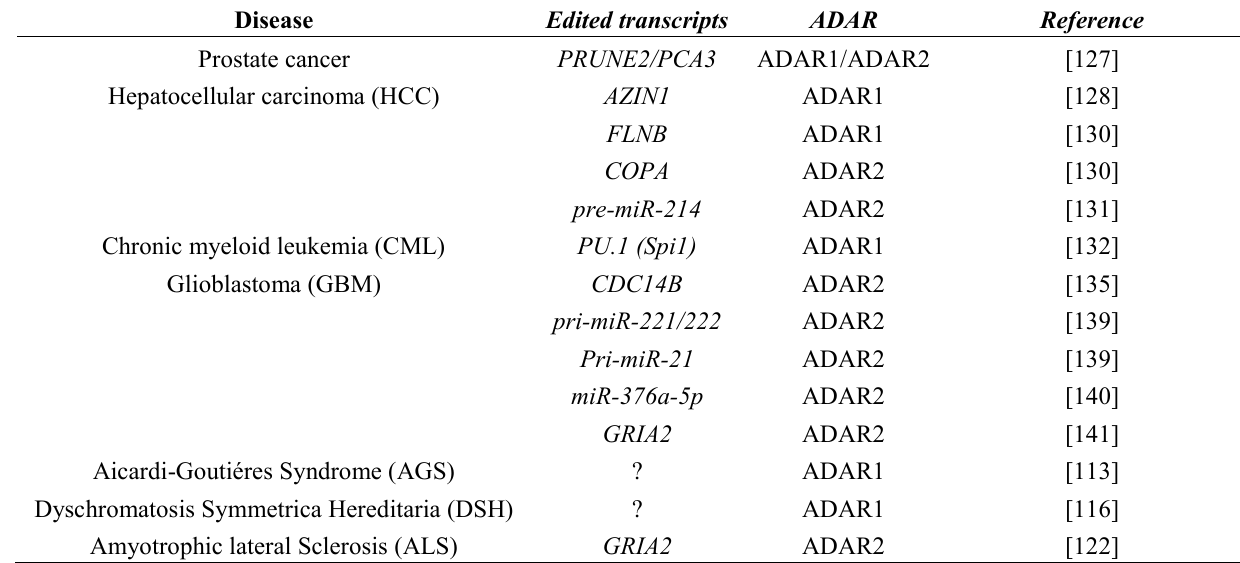
Table 1. List of diseases associated with human